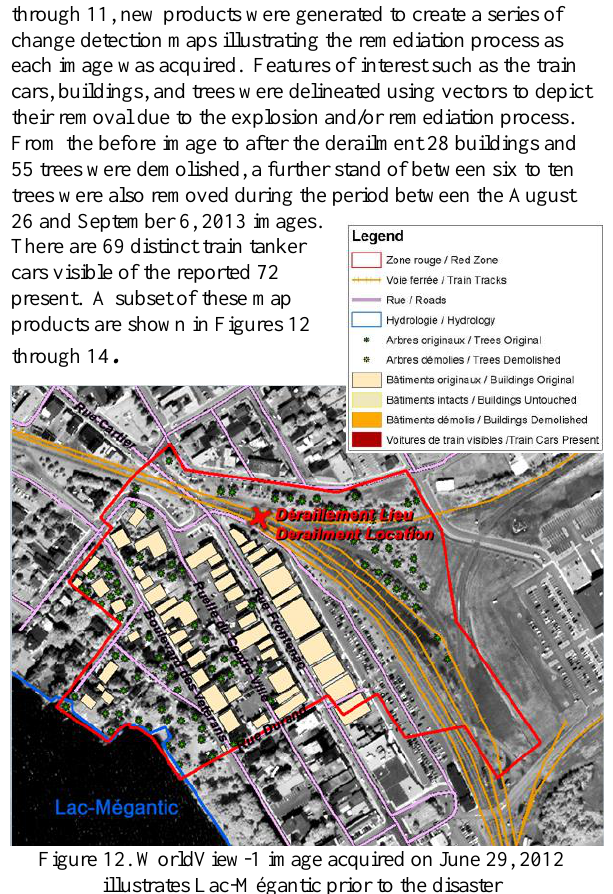
Figure 12. WorldView-1 image acquired on June 29, 2012 illustrates Lac-Mégantic prior to the disaster © DigitalGlobe 2012